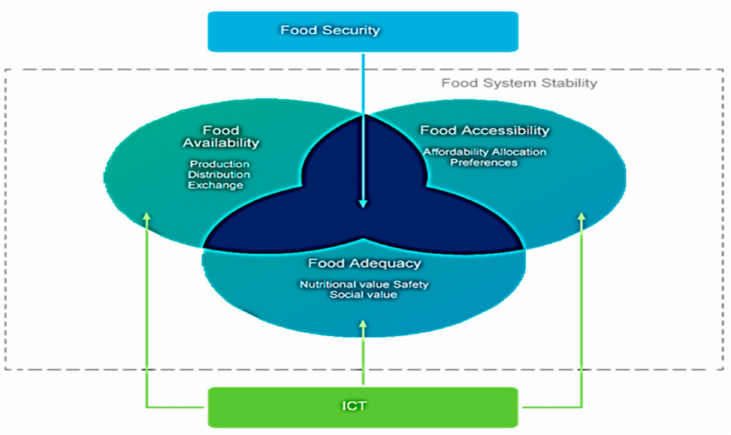
Figure 4. Sustainable food system and information and communications technology (ICT)